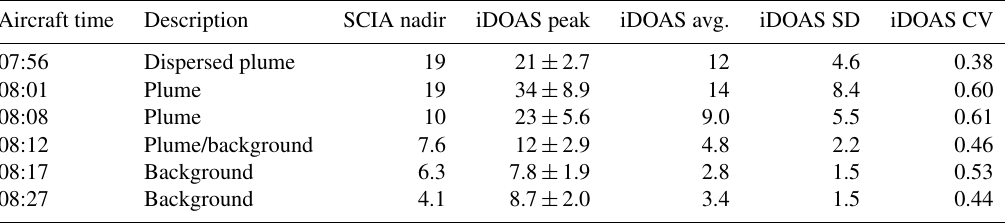
Figure 16. A comparison of the airborne DOAS 10s moving average NO 2 vertical column densities with SCIAMACHY on 14 August 2007. Data presentation is as in Fig. 9; however, since SCIAMACHY is a whiskbroom instrument, the time for each satellite pixel is shown in each pixel. SCIAMACHY overpass was at around 07:40UTC. Table 5. Cases of background and plume measurements identified from the iDOAS measurements on 14 August 2007. Aircraft time is given in UTC. SCIA nadir refers to the TVCD value in the SCIAMACHY pixel at aircraft nadir. iDOAS peak refers to the peak VCD within the OMI pixel at aircraft nadir. iDOAS average is the line-averaged iDOAS measurements within the SCIAMACHY pixel at aircraft nadir, and iDOAS standard deviation is the iDOAS-measured variability within this SCIAMACHY pixel expressed as a standard deviation. iDOAS CV is the coefficient of variation (or relative standard deviation) of the measured variability. All column densities are expressed in petamoleccm − 2